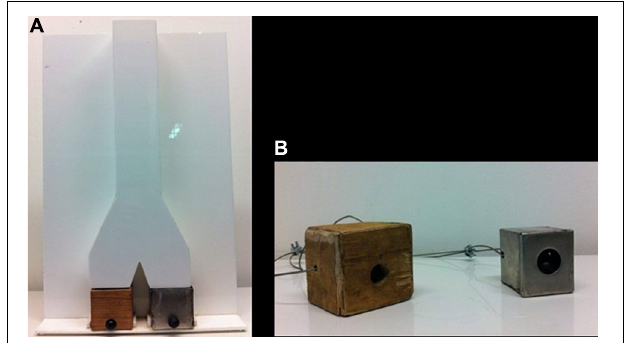
FIGURE 4 | Testing box used in familiar boxes (wooden and metal) conditions (A) and sound-making training boxes (B) in Experiment